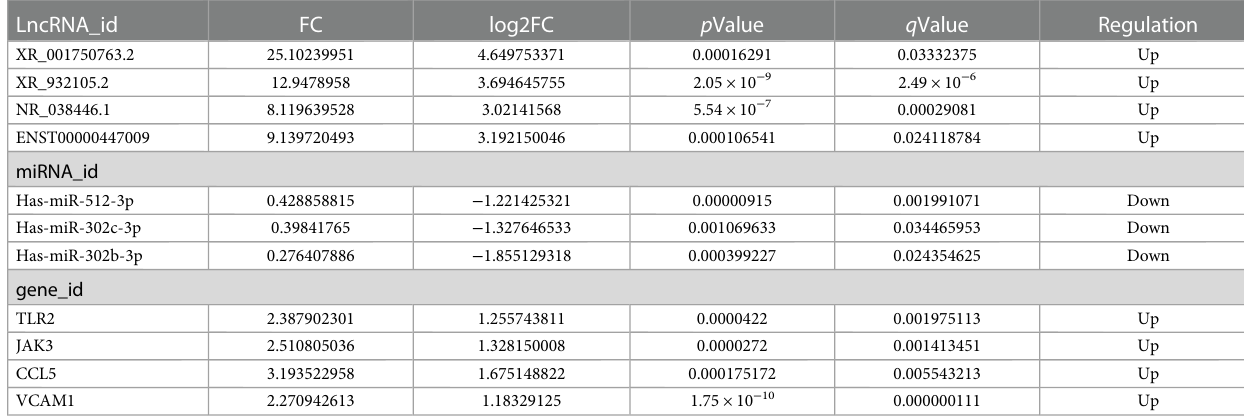
DE, differentially expressed; LAA, left atrial appendage; FC, fold change.